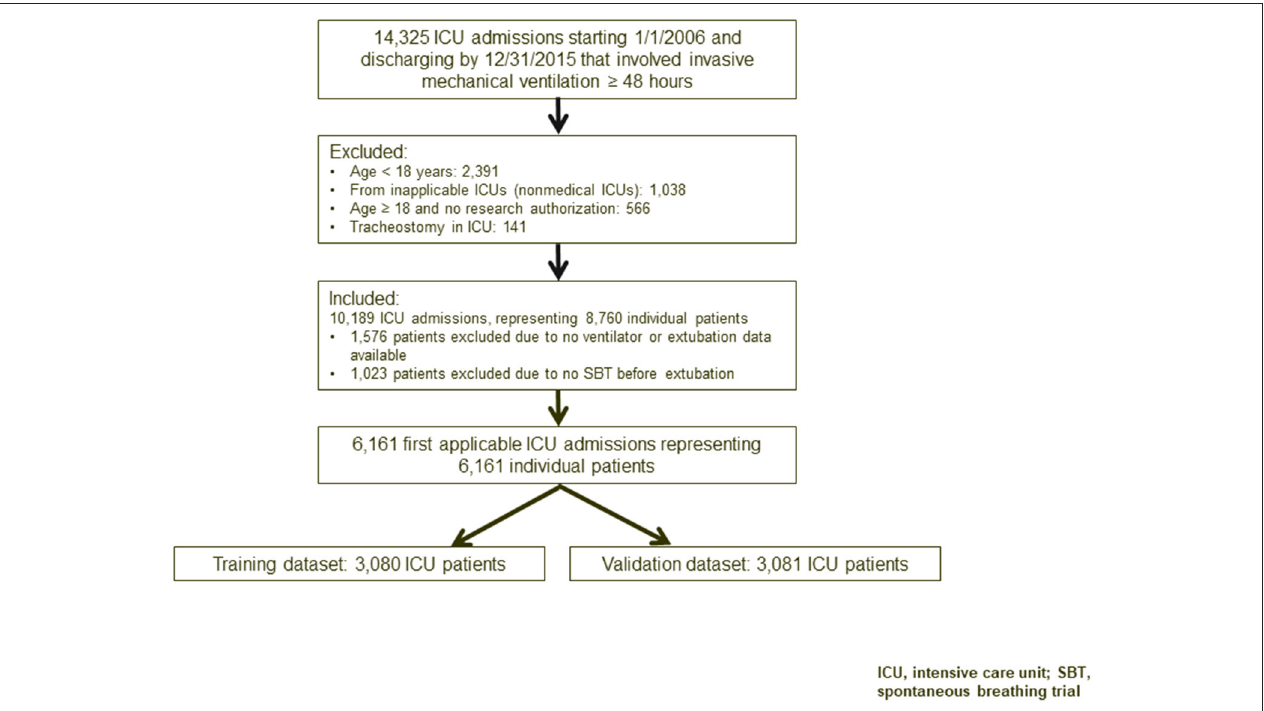
FIGURE 1 | Flowchart of study participants. ICU, intensive care unit; SBT, spontaneous breathing